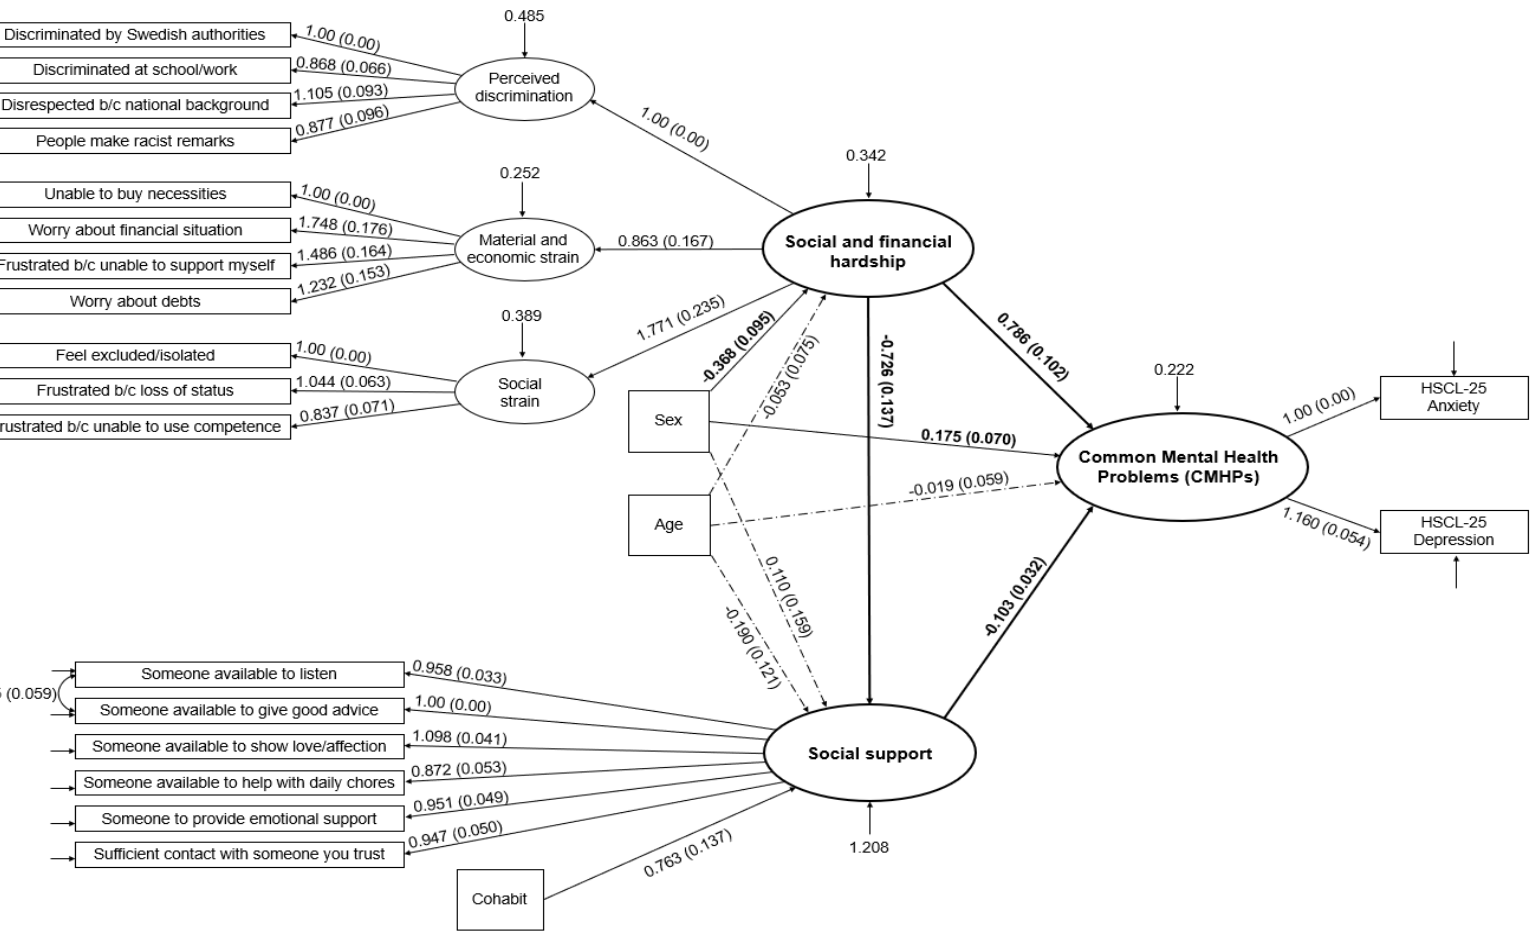
Figure 2. Full Structural Equation Model of Common Mental Health Problems (CMHPs) regressed on the latent variables social and financial hardship and social support. The displayed estimates for regression weights are unstandardized (B) with robust standard error in parentheses. Significant weights are indicated by solid-line arrows. Dashed-line arrows indicate nonsignificant regression weights. The weight estimates of main interest are in bold. Values for residual variances of indicator variables (boxes) are not included in the figure for readability issues (empty arrows signify that variances were part of the full structural equation model).